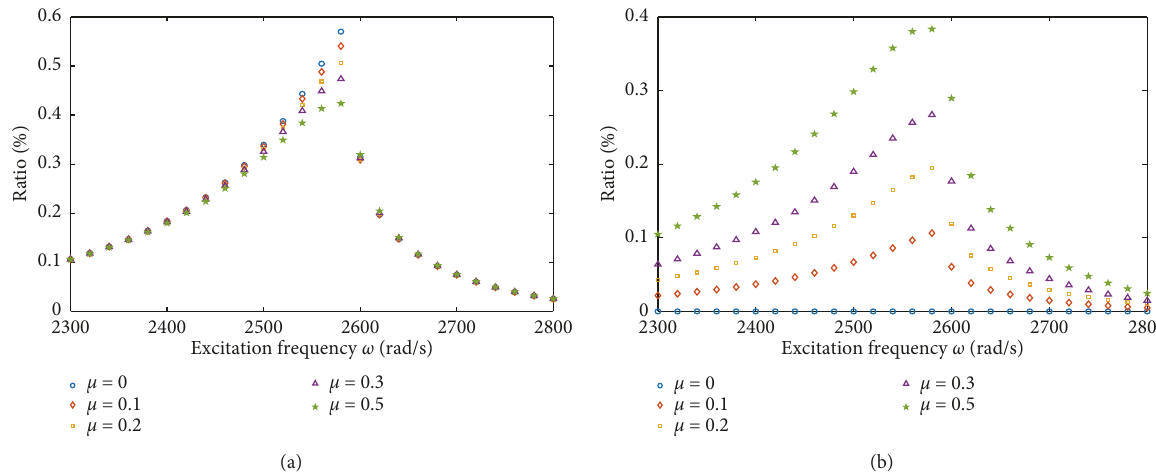
Figure 12: The energy ratio at different friction coefficients. (a) The ratio of energy storage by the contact force. (b) The ratio of energy consumption by the friction force.